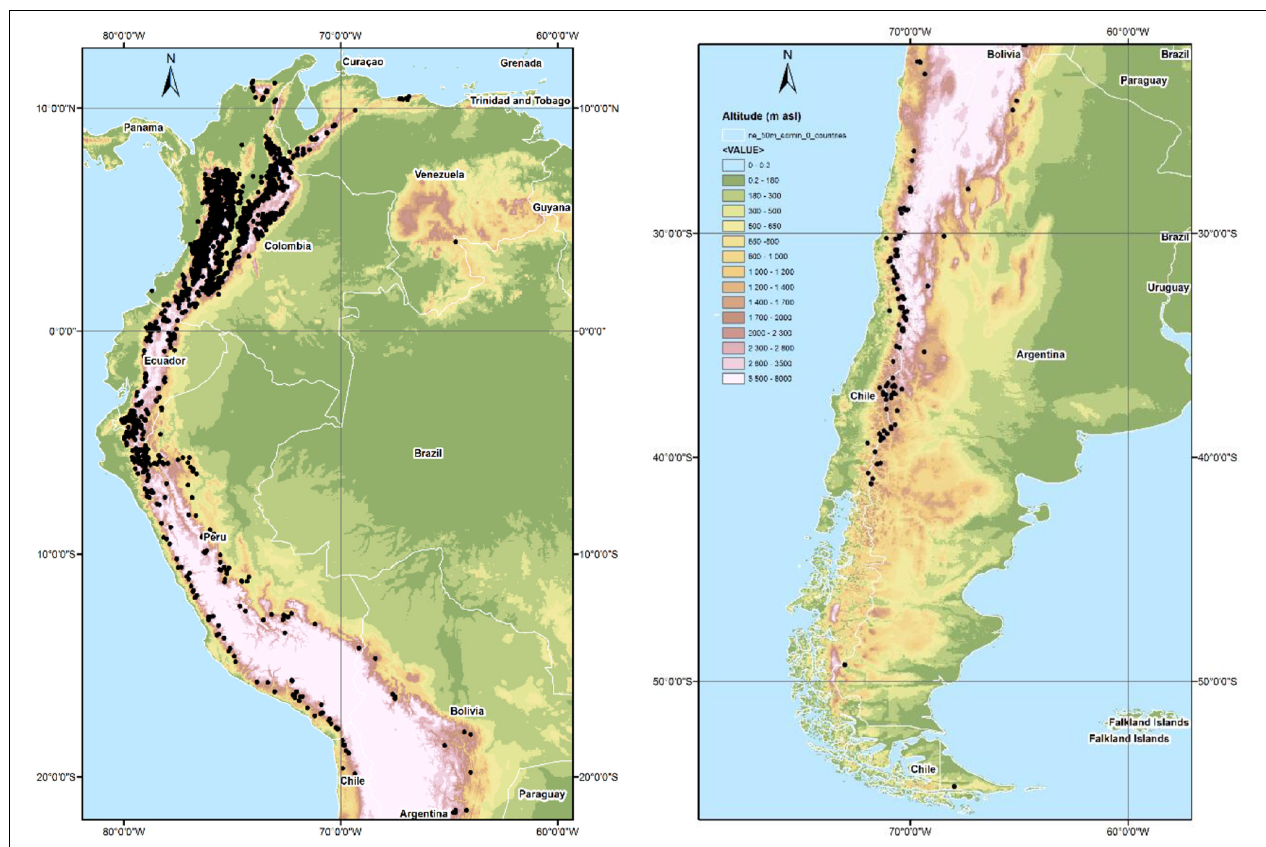
FIGURE 2 | Total number of surface stations (meteorological and hydrological) between 1,001 to 2,000 m. Source: National Meteorological and hydrological Services from Bolivia, Chile, Colombia, Ecuador, Peru, Venezuela, and